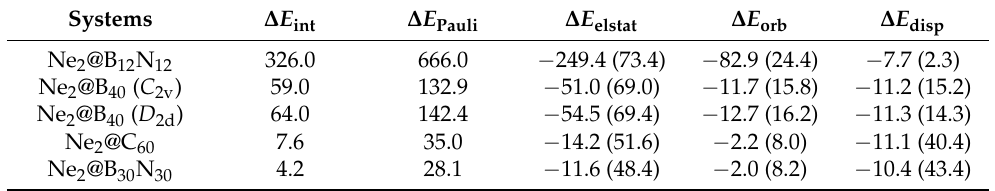
Table 5. Total interaction energy values and components in kcal mol −1 obtained from EDA results Ne 2 @cage systems using Ne 2 and the cage as the fragments.